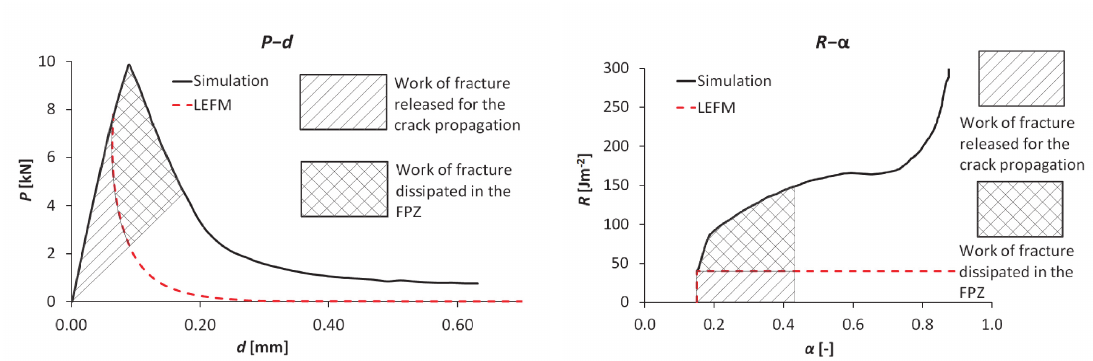
Figure 2: Indication of the individual portions of work of fracture at the current stage of fracture process in the loading diagram (left) and R -curve